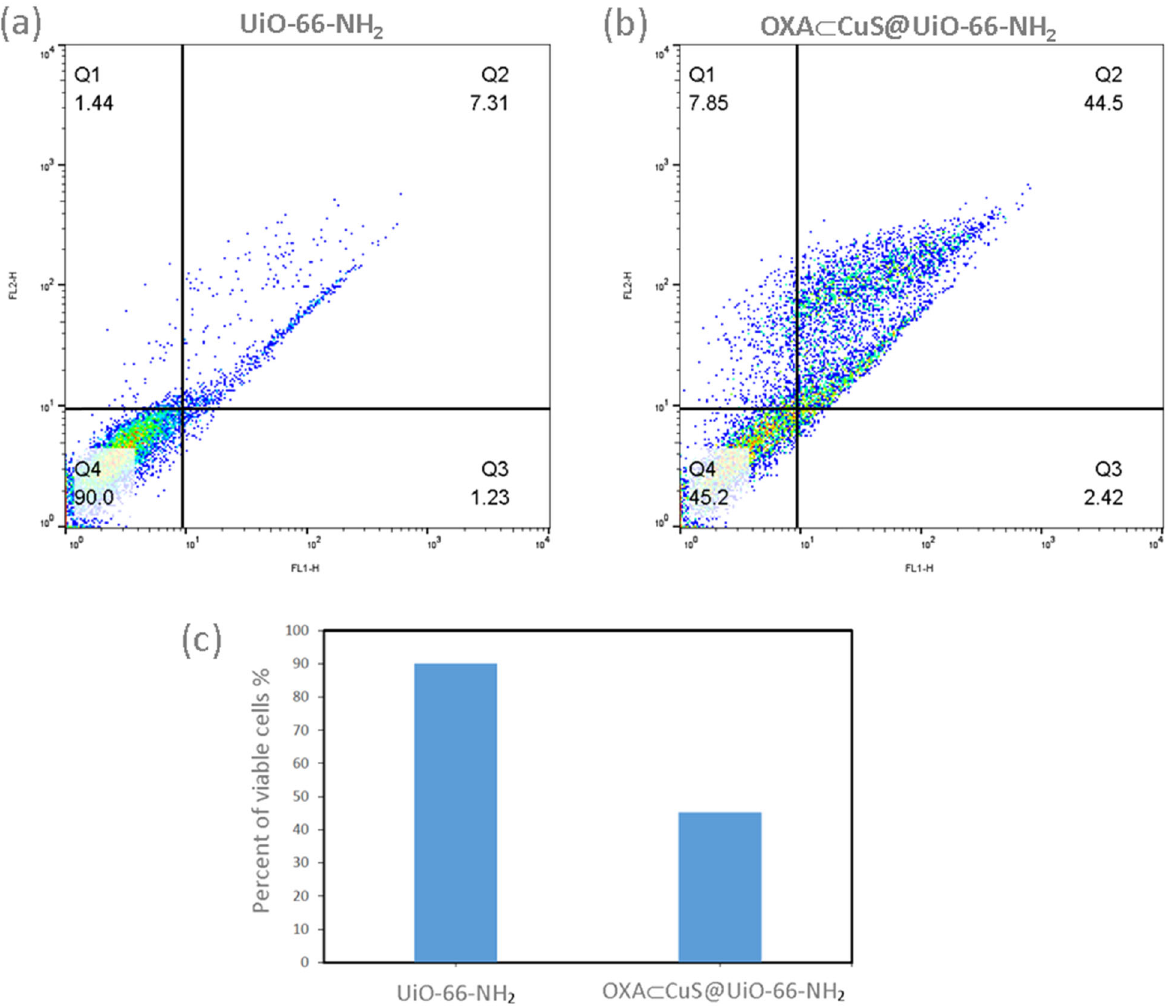
Fig. 7 Flow cytometry charts of UiO-66-NH 2 and OXA-CuS@UiO-66-NH 2 ( a and b ) and statistics ( c